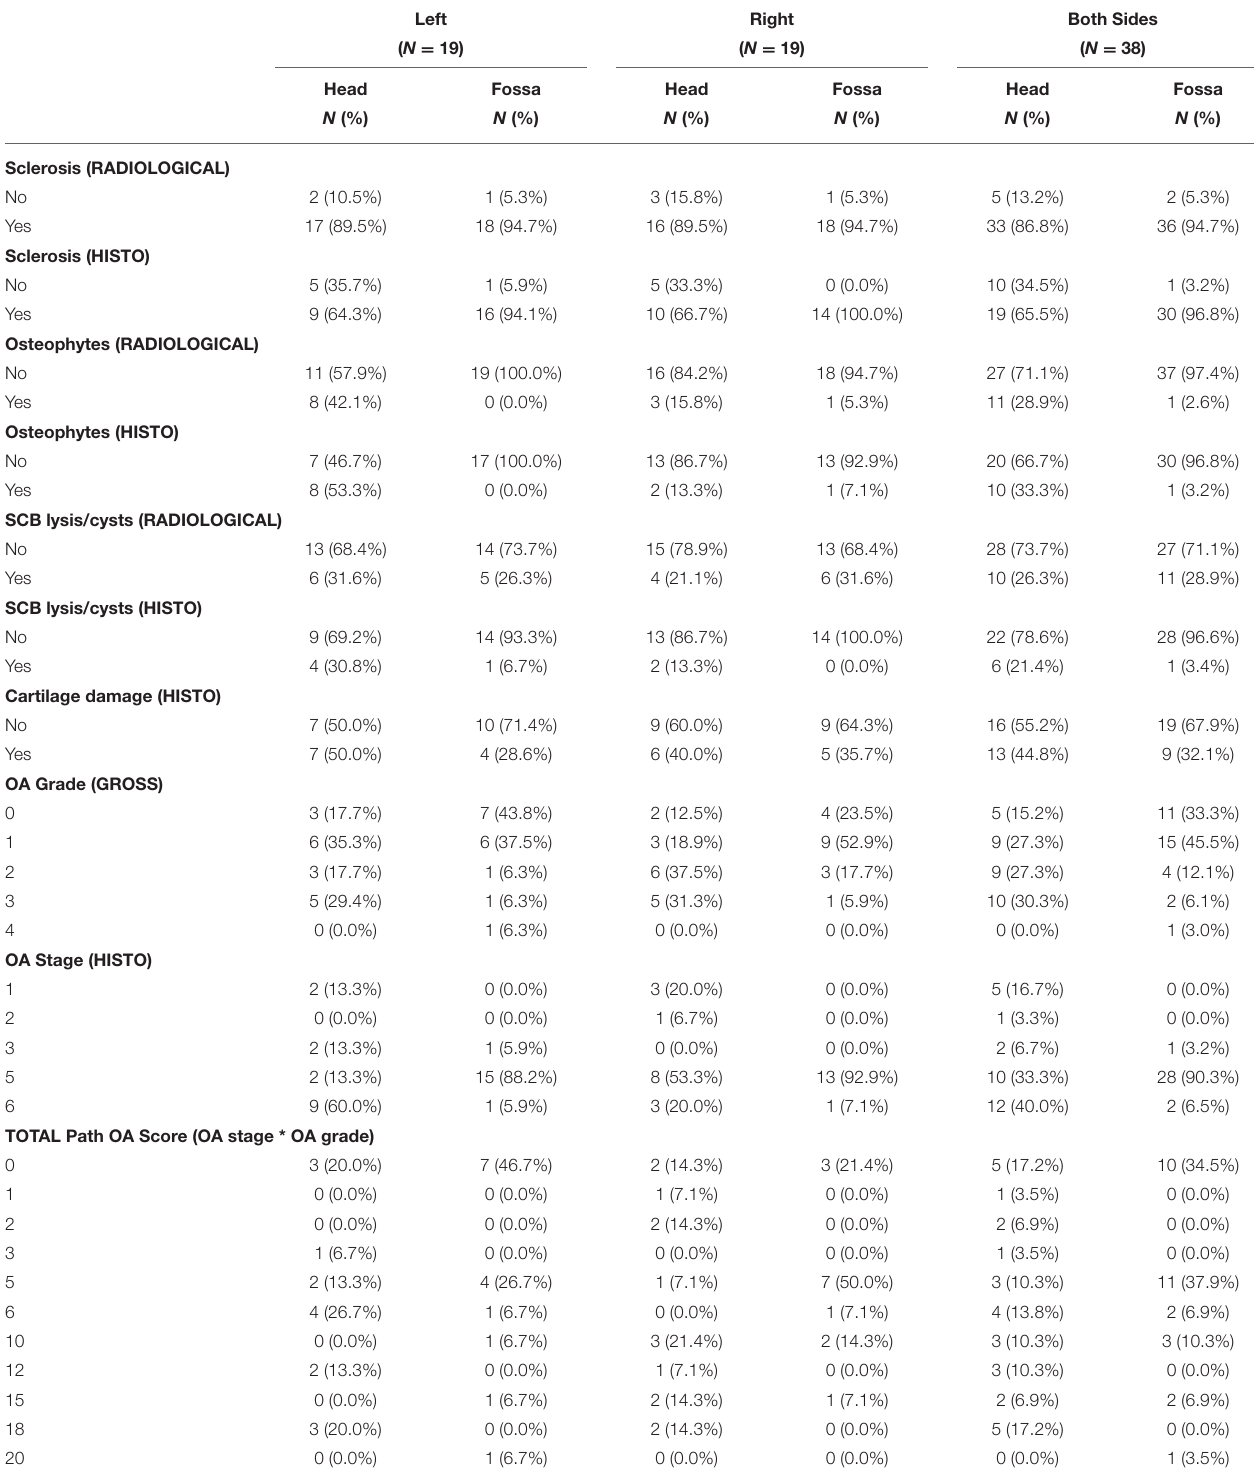
TABLE 3 | Summary of frequency and proportion of assessment. Left Right Both Sides ( N = 19) ( N = 19) Head Fossa Head Fossa